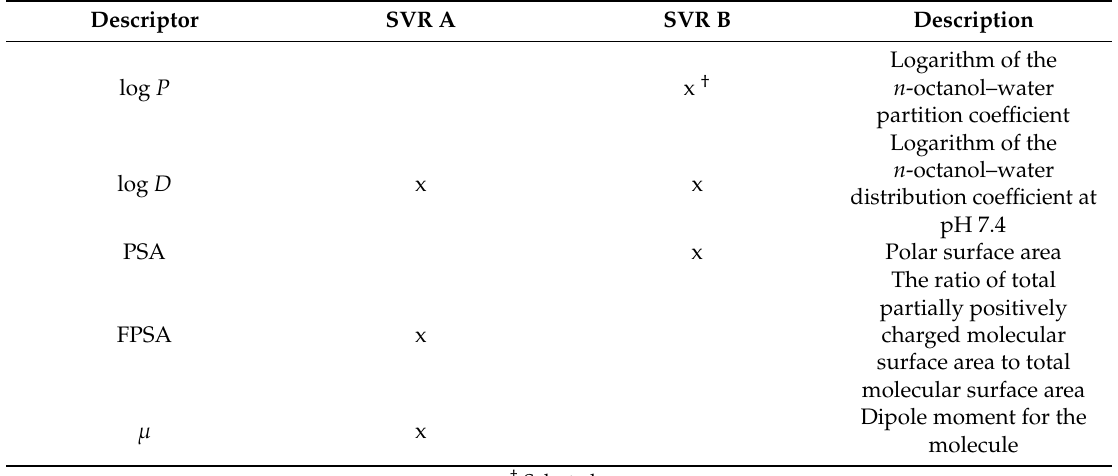
Table 1. Descriptor selected as the input of support vector regression (SVR) models in the ensemble and their descriptions.